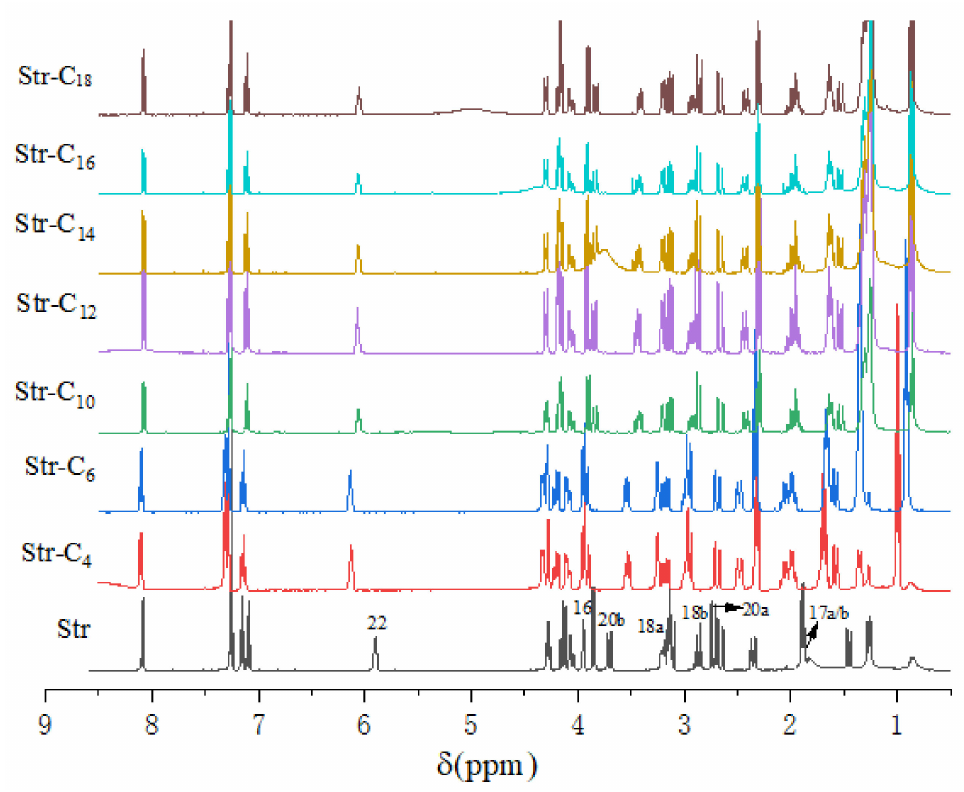
Figure 2. 1 H NMR spectra of Str and its ion-pairs in CDCl 3 . Table 1. 1 H NMR chemical shifts ( δ , ppm) of Str and its ion-pairs in CDCl 3